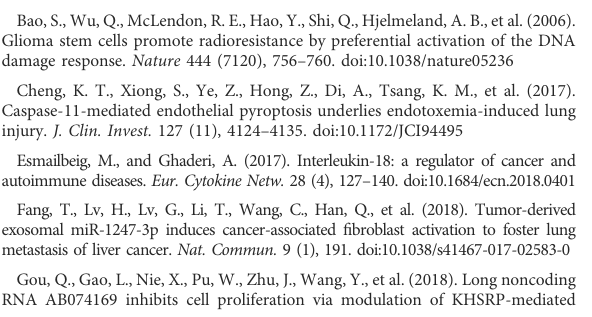
SUPPLEMENTARY FIGURE S1 KMcurvesforthedifferentsubgroupsofpatientsinTCGA (A) ,CGGA_693 (B) , and CGGA_325 (C) datasets. SUPPLEMENTARY FIGURE S2 Relationship between the risk score and glioma clinicopathological parameters in the CGGA_693 dataset (A) and CGGA_325 dataset (B) . A, astrocytoma; O, oligodendroglioma; GBM, glioblastoma. * p < 0.05, ** p < 0.01, and *** p < 0.001. ns, no signi fi cance. SUPPLEMENTARY FIGURE S3 Correlation between the PRL classi fi er and the microenvironment in CGGA_693 and CGGA_325 cohorts. (A,D) The in fi ltration degree of the 22 in fl ammatory cells between the two classi fi cations. (B,E) The expression of the eight immune checkpoints between the two classi fi cations. (C,F) The stromal, immune, and ESTIMATE scores, along with tumour purity between the two classi fi cations. * p < 0.05, ** p < 0.01, and *** p < 0.001. ns, no signi fi cance. SUPPLEMENTARY FIGURE S4 KM survival curves for the different subgroups of patients with glioma in the high- and low-risk groups